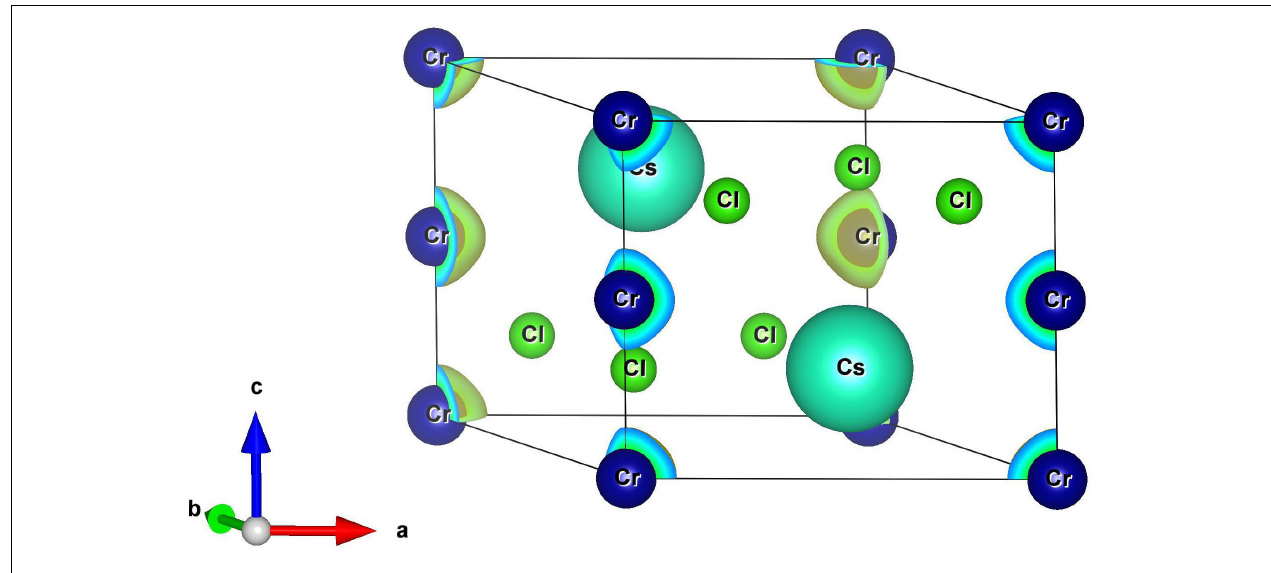
FIGURE 6 | Spin-density for the CsCrCl 3